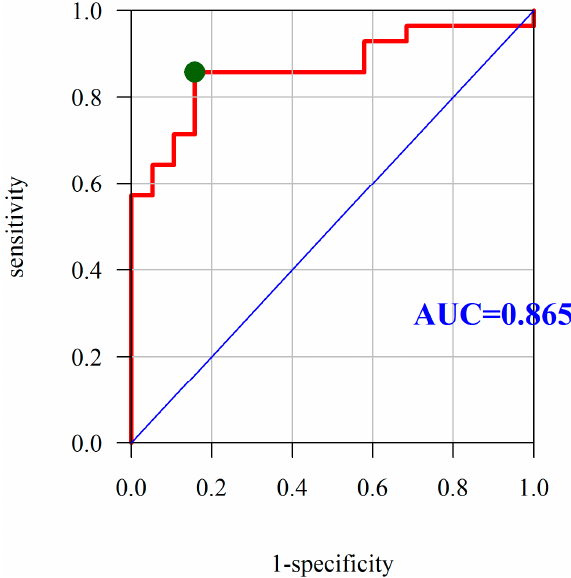
Figure 3. Diagnostic utility of PON-1 was assessed as the predictor of Crohn’s disease activity based on the analysis of ROC curves. Abbreviations: PON-1, paraoxonase-1; ROC, receiver operating characteristic; AUC, area under the ROC curve; red line mean AUC: area under the ROC curve and green point mean the true cut-off value of the ROC curve.